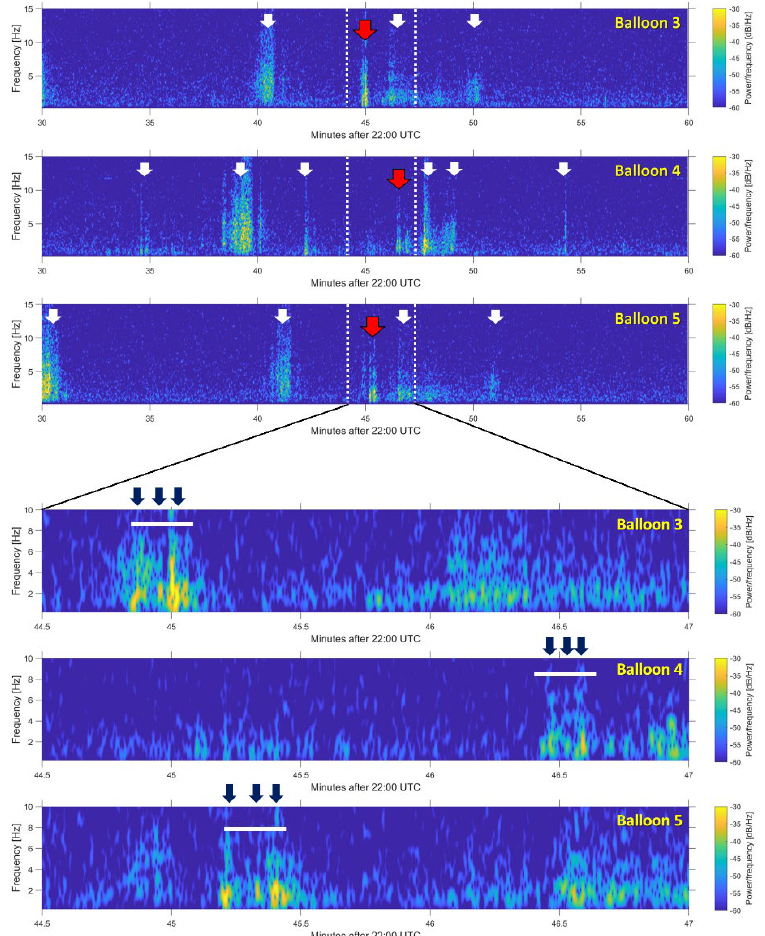
Figure 7. Spectrogram for the period between 22:30 UTC and 23:00 UTC (top panel), and up to 15 Hz. The red arrows point to the signals from Apollo. The white arrows indicate acoustic energy spikes associated with noise and/or signals of unknown origin. The zoomed-in region between 22:44:30 UTC and 23:47:00 UTC (bottom panel) and up to 10 Hz highlights the Apollo signals, which are denoted with the white bars and dark blue